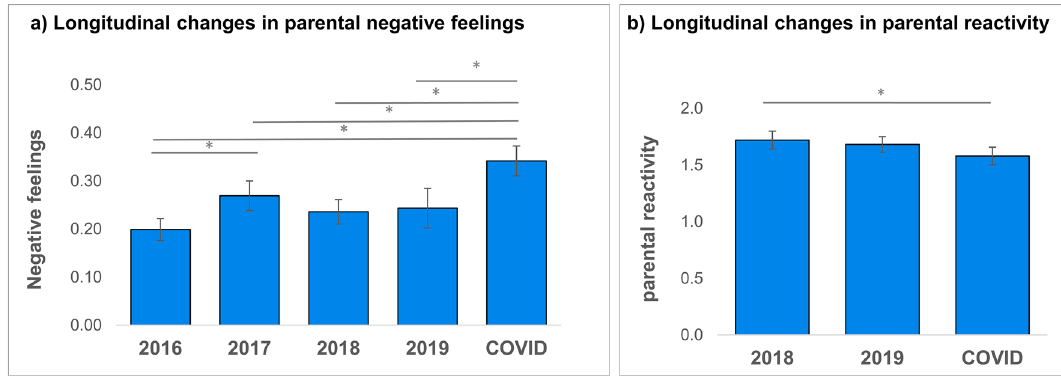
Figure 1. Longitudinal changes in parental negative feelings ( a ) and parental overreactivity ( b ). Asterisk indicate significant differences ( p < .05).